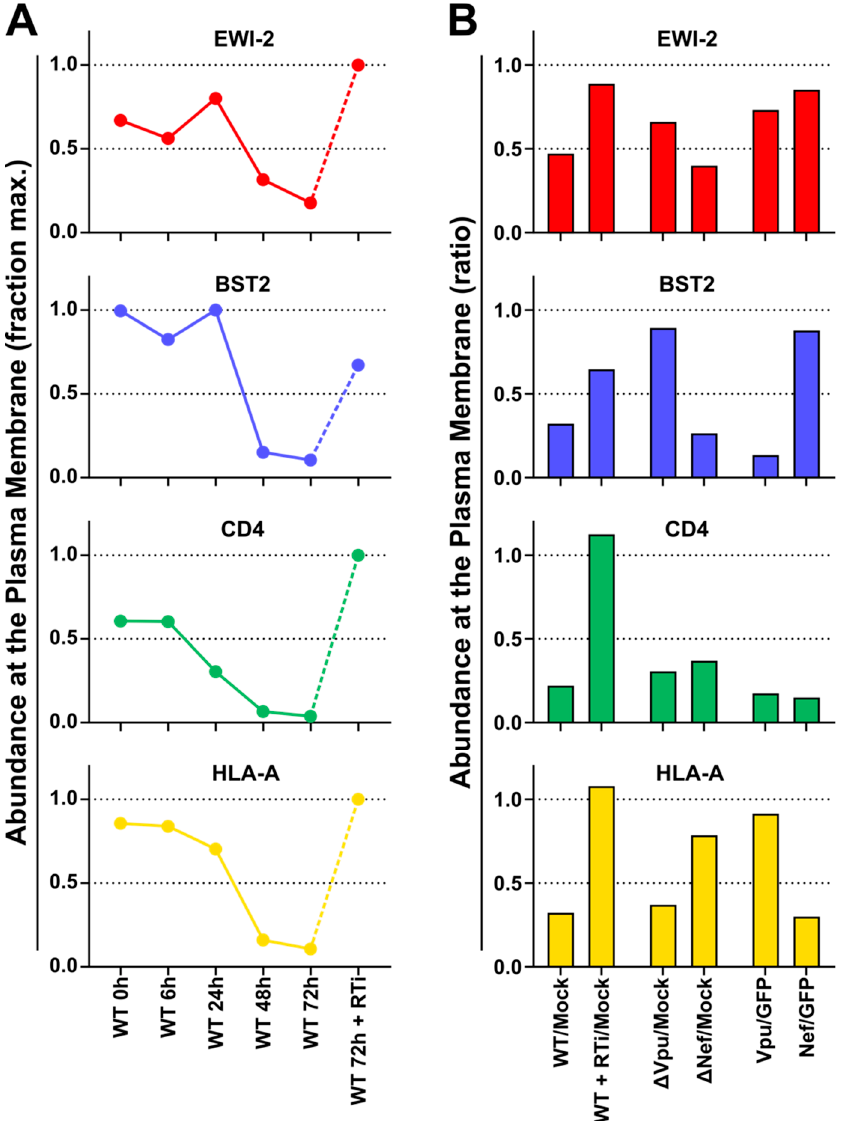
Figure 4. Plasma membrane EWI-2 is downregulated by Vpu. ( A ) Temporal expression profiles of cell surface EWI-2 (red, upper panel) or indicated control proteins (blue / green / gold, lower panels) in WT HIV-1-infected CEM-T4 T cells (reanalysis of data from [53]). Plasma membrane proteins were subjected to TMT-based quantitative proteomics 0 (uninfected), 6, 24, 48, and 72 h after infection, or 72 h after infection in the presence of reverse transcriptase inhibitors (RTi). Twelve unique peptides were used for EWI-2 quantitation. Relative abundances (fraction of maximum TMT reporter ion intensity) are shown. ( B ) Abundance of EWI-2 (red, upper panel) or indicated control proteins (blue / green / gold, lower panels) in control CEM-T4 T cells or CEM-T4 T cells infected with WT HIV-1 in the presence / absence of RTi, infected with Vpu- or Nef-deficient HIV-1, or transduced with Vpu or Nef as single genes (reanalysis of data from [53]). Plasma membrane proteins were subjected to Stable Isotope Labelling with Amino acids in Cell culture (SILAC)-based quantitative proteomics 72 h after infection (3 × 3-way comparisons). Twelve (WT HIV-1 +/ − RTi), nine ( ∆ Vpu / ∆ Nef HIV-1) or 14 (Vpu / Nef) unique peptides were used for EWI-2 quantitation. Ratios of abundances to mock-infected CEM-T4 T cells (WT HIV-1 +/ - RTi and ∆ Vpu / ∆ Nef HIV-1) or GFP-transduced CEM-T4 T cells (Vpu / Nef) are shown. Note that ( A ) and ( B ) show data from two di ff erent quantitative proteomic methods, as described above and in Materials and Methods.